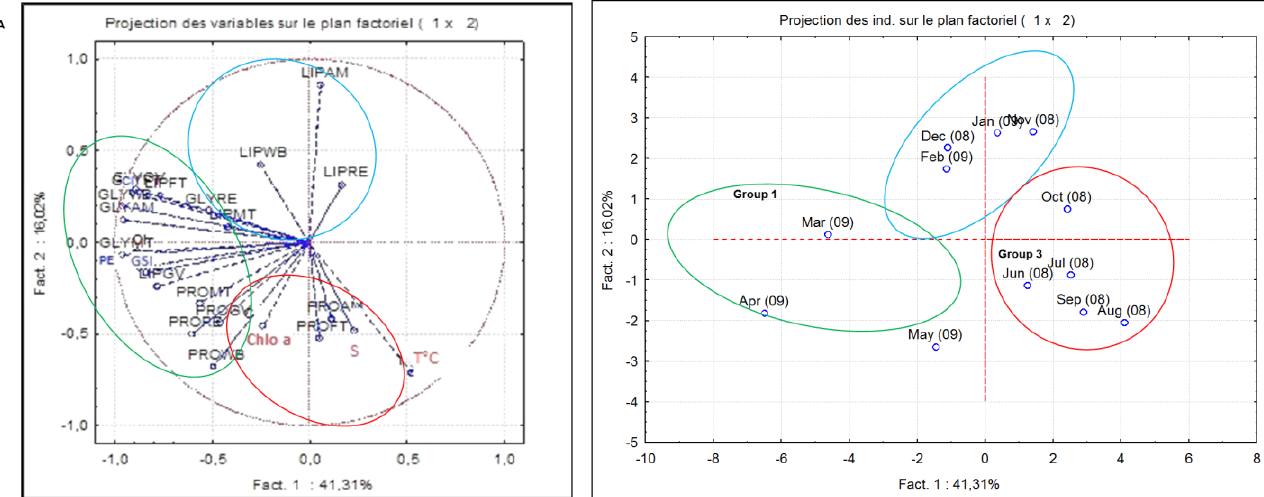
Figure 5. Principal analysis component (PCA) represented by two factors F1 and F2 and produced by the biochemical parameters and reproductive indices of Mactra stultorum and the environmental condition. Projection of the variables on the factor-plane (1-2) (A) and projection of the cases on the factor-plane (1-2) (B) PRO: protein, GLY: glycogen, LIP: total lipid, FT : foot , GV: gonad-visceral mass, MT: mantle, AM : adductor muscle, RE: rest, BW: whole body, CI: condition index, GSI: gonado-somatic index, T°C: water temperature, Chlo a : chlorophyll a , S: